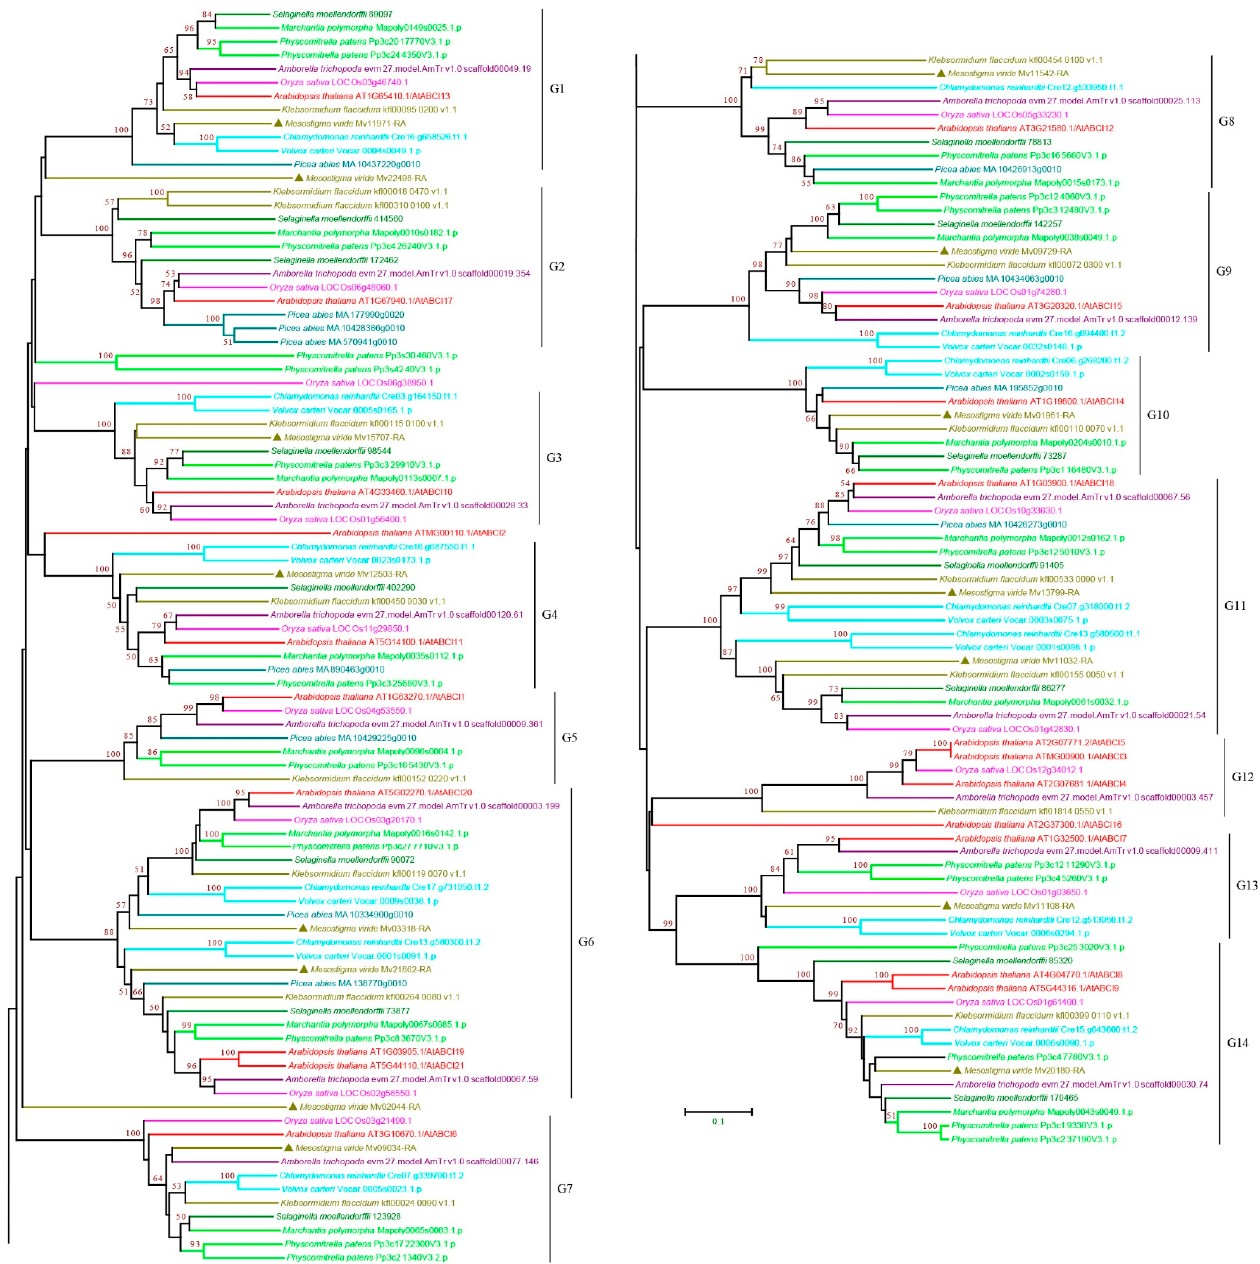
Figure 8. Phylogenetic analysis of ABCG subfamily proteins from 11 evolutionarily representative plant species. A neighbor-joining (NJ) tree was generated using MEGA7 with 1000 bootstrap repli- cates, and bootstrap values >50% are shown on the branches. ABCGs include two major groups: the white–brown complex (WBC), and pleiotropic drug resistance proteins (PDRs). The M. viride pro- teins are highlighted by triangles.